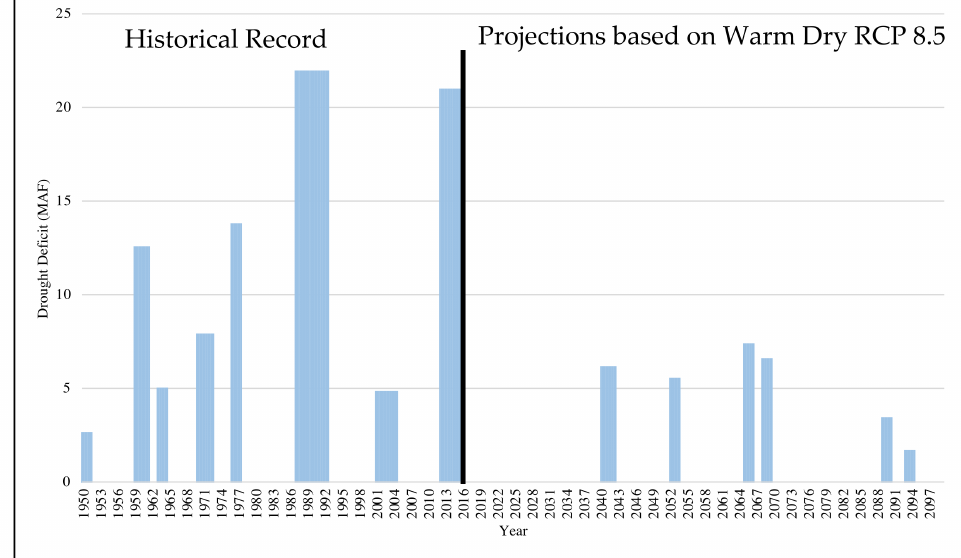
Figure 3. San Joaquin drought deficit quantities historical (1950–2015) and Cool Wet RCP 4.5 (2020–2099). The width of each bar represents the length of drought and the height of each bar represents the deficit (or magnitude) of the drought. (Note: 1 MAF = 1233 million cubic